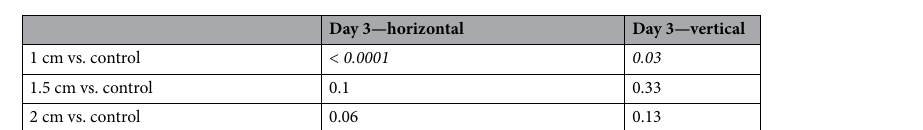
Table 2. Horizontal and vertical inhibition rates comparison between control and various distances of CHX— p -values. Significant values are in